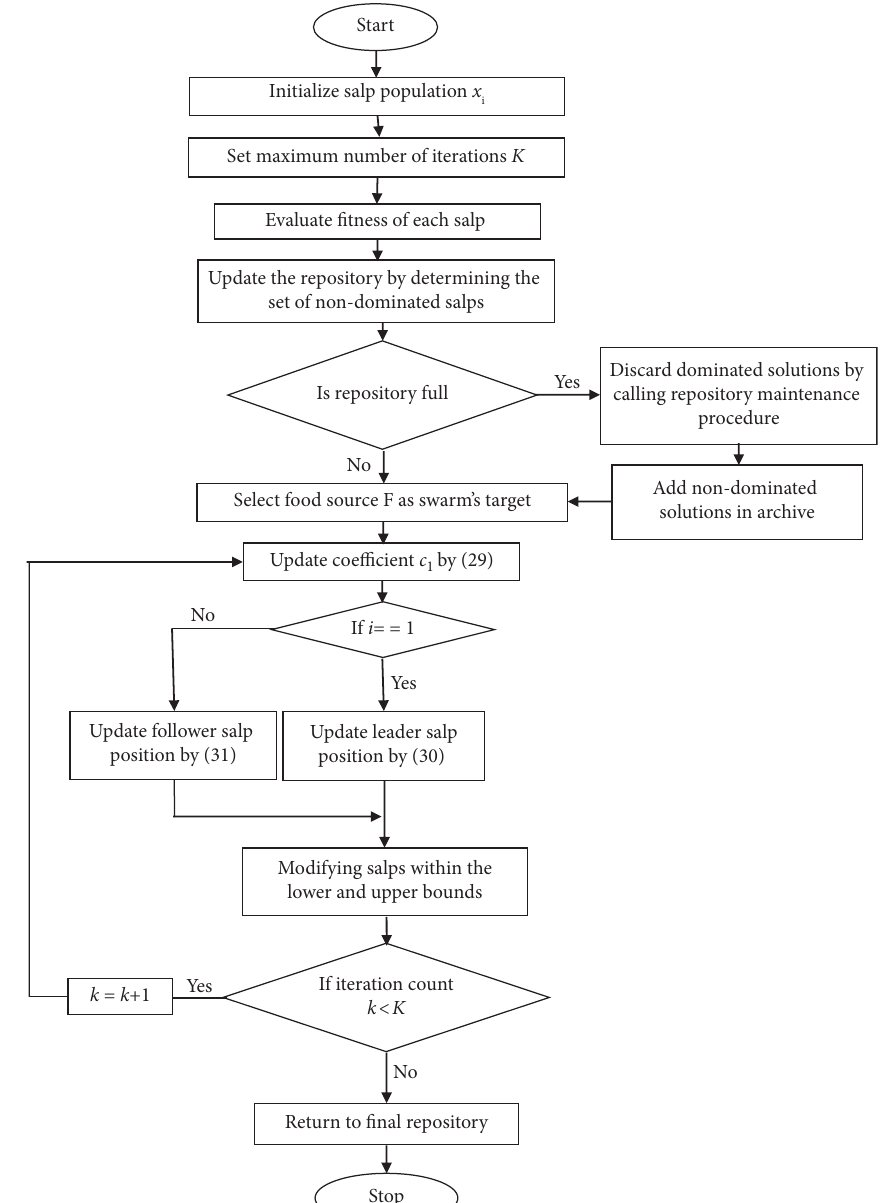
Figure 1: Flow chart of proposed MOSSA